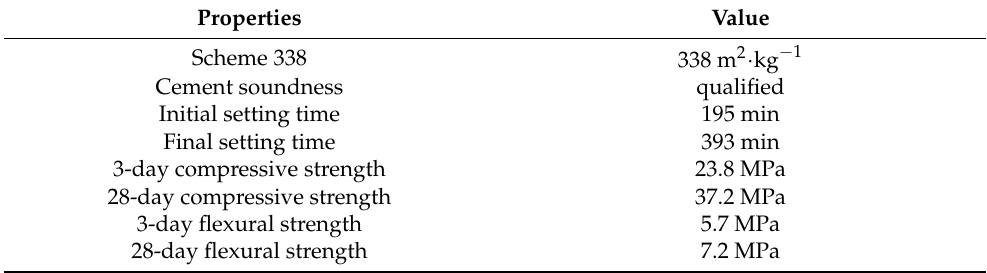
Table 1. Basic properties of cement.